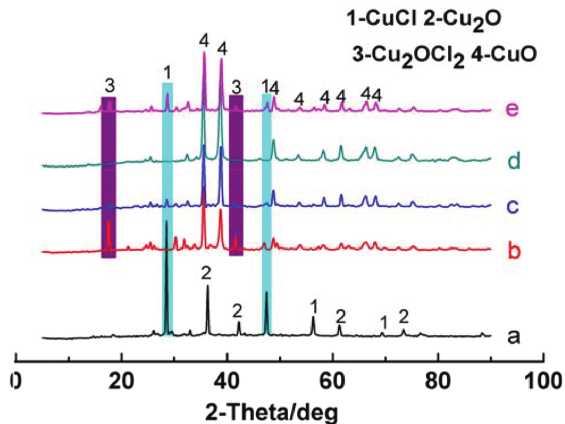
Figure 6: XRD patterns of the raw materials and roasted samples at 450°C: (a) raw materials, (b) for 30 min and oxygen, (c) for 60 min and oxygen, (d) for 90 min and oxygen, (e) for 90 min and air.